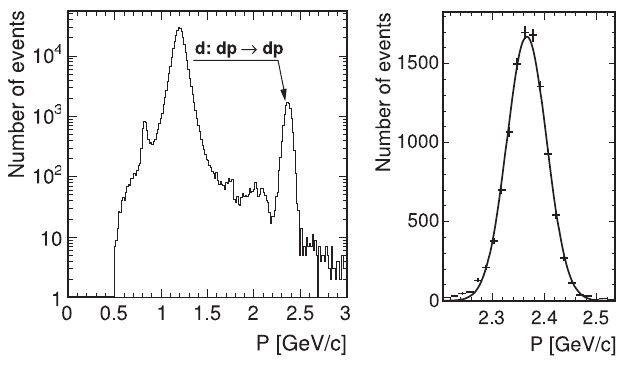
FIG. 12. Left: Single-track momentum spectrum for the dp data at 2 : 40 GeV =c on a logarithmic scale. Right: Fit result of the elastic peak region with a Gaussian function on a linear